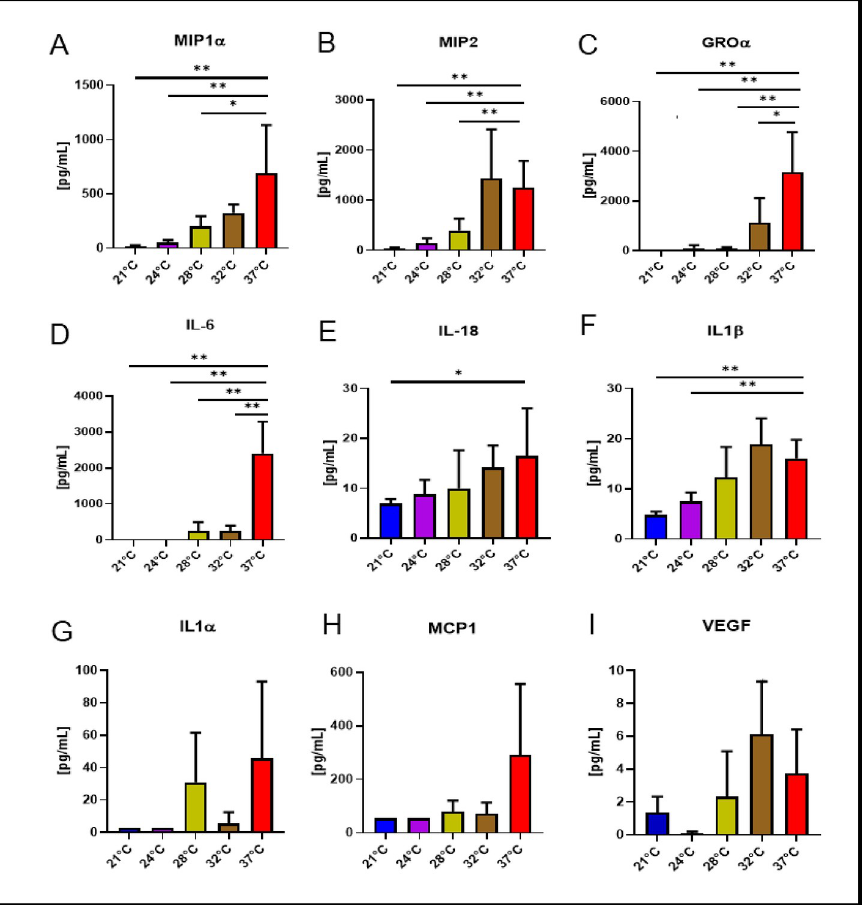
Fig 3. Cytokines and chemokines in the perfusate. After 4 hours of EVLP, concentrations of chemokines MIP1 α (Fig 3A) and MIP2 (Fig 3B) collected from the 28˚C, 24˚C and 21˚C conditions were significantly lower than at 37˚C ( p < 0 . 05 to p < 0 . 01 ). Concentrations of GRO- α (Fig 3C) and IL-6 (Fig 3D) collected from all the subnormothermic conditions were significantly lower than at 37˚C ( p < 0 . 05 to p < 0 . 01 ). Concentration of IL-18 (Fig 3E) at 21˚C was significantly lower than at 37˚C ( p < 0 . 05 ), whereas IL-18 levels detected at 24˚C, 28˚C and 32˚C were lower but not significantly different from levels observed at 37˚C. Concentrations of IL-1 β (Fig 3F) at 21˚C and 24˚C were lower than at 37˚C ( p < 0 . 01 ).For IL-1 α (Fig 3G), MCP-1 (Fig 3H) and VEGF (Fig 3I), their concentrations showed lower values compared to 37˚C.